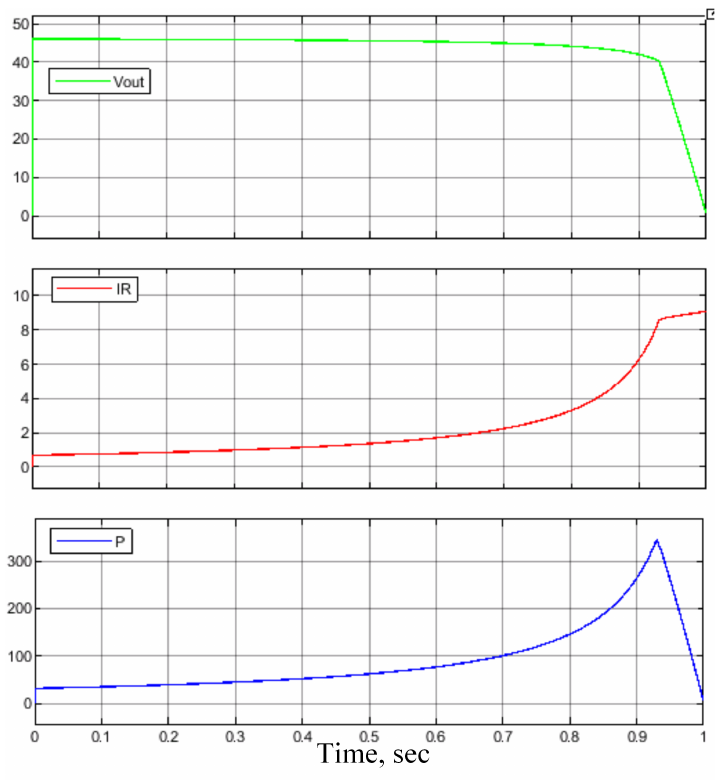
Figure 10. Dynamic responses of the solar panel simulator.